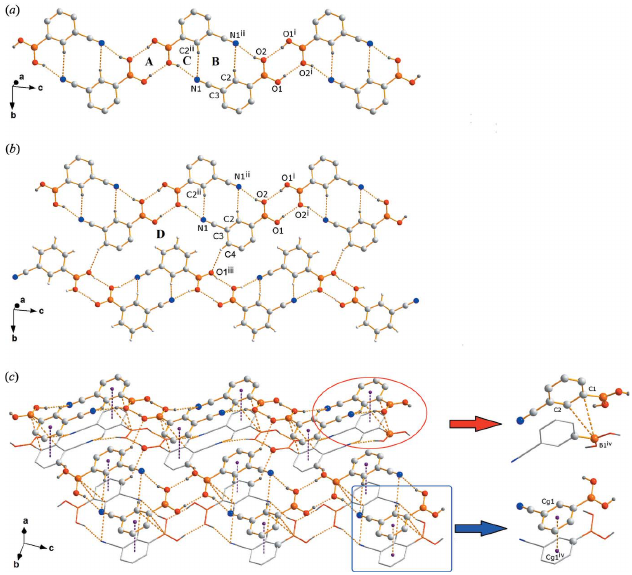
Figure 3 Hydrogen-bonding motifs and (cid:2) – (cid:2) interactions found in the crystal structure of (I). [Symmetry codes: (i) 2 (cid:5) x , 1 (cid:5) y , 1 (cid:5) z ; (ii) 1 (cid:5) x , 1 (cid:5) y , (cid:5) z ; (iii) (cid:5) 1 + x , 3 (cid:5) y , (cid:5) 1 + z ; (iv) (cid:5) 1 + x , y , z 2 2